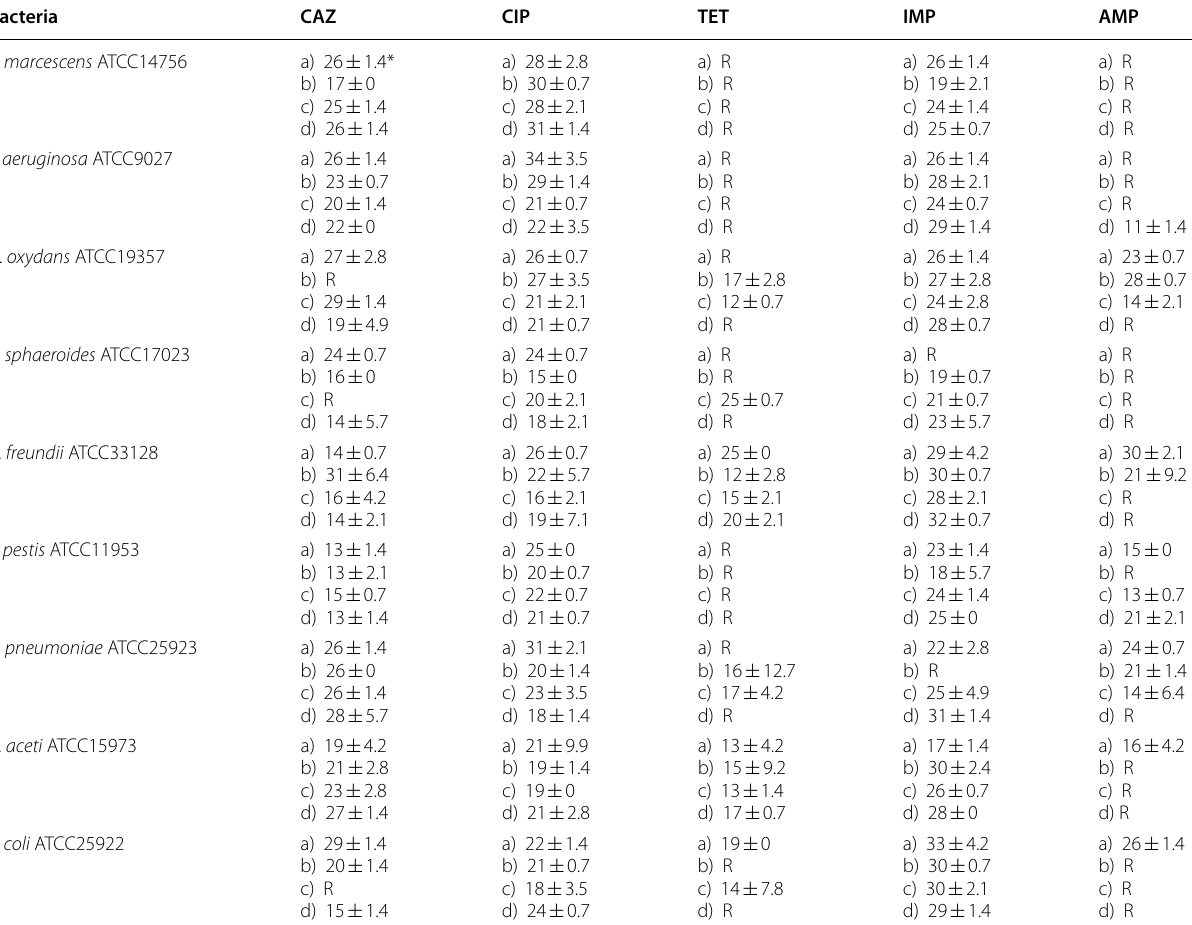
Table 1 Antibiotics susceptibility profile for selected Gram‑negative bacteria as read in mean diameter of zones of inhibition (mm) after exposure to acoustic treatment at 5000 Hz/90 dB compared with